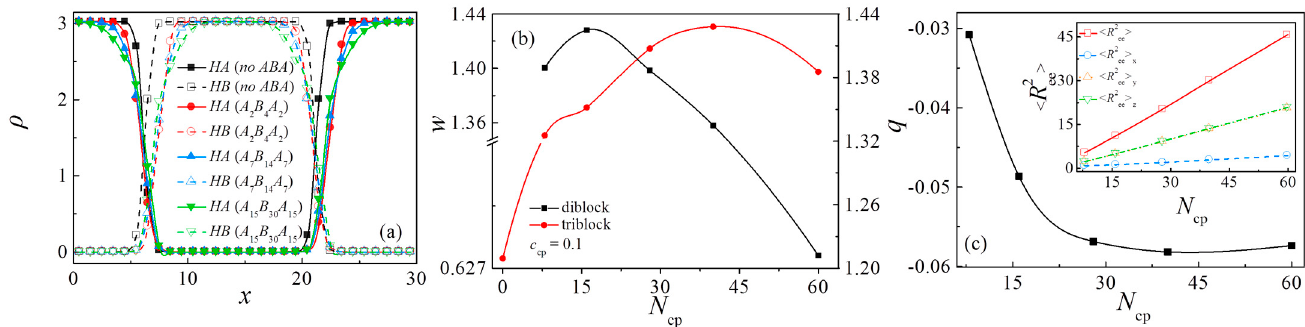
Figure 5. ( a ) Density profiles of homopolymer beads and ( b ) interface thickness in ternary blends at copolymer concentration of c cp = 0.1. ( c ) Orientation parameter of triblock copolymers as a function of their chain length N cp . The inset indicates the mean-squared, end-to-end distance < R ee2 > and the three principal components < R ee2 > x , < R ee2 > y , < R ee2 > z .